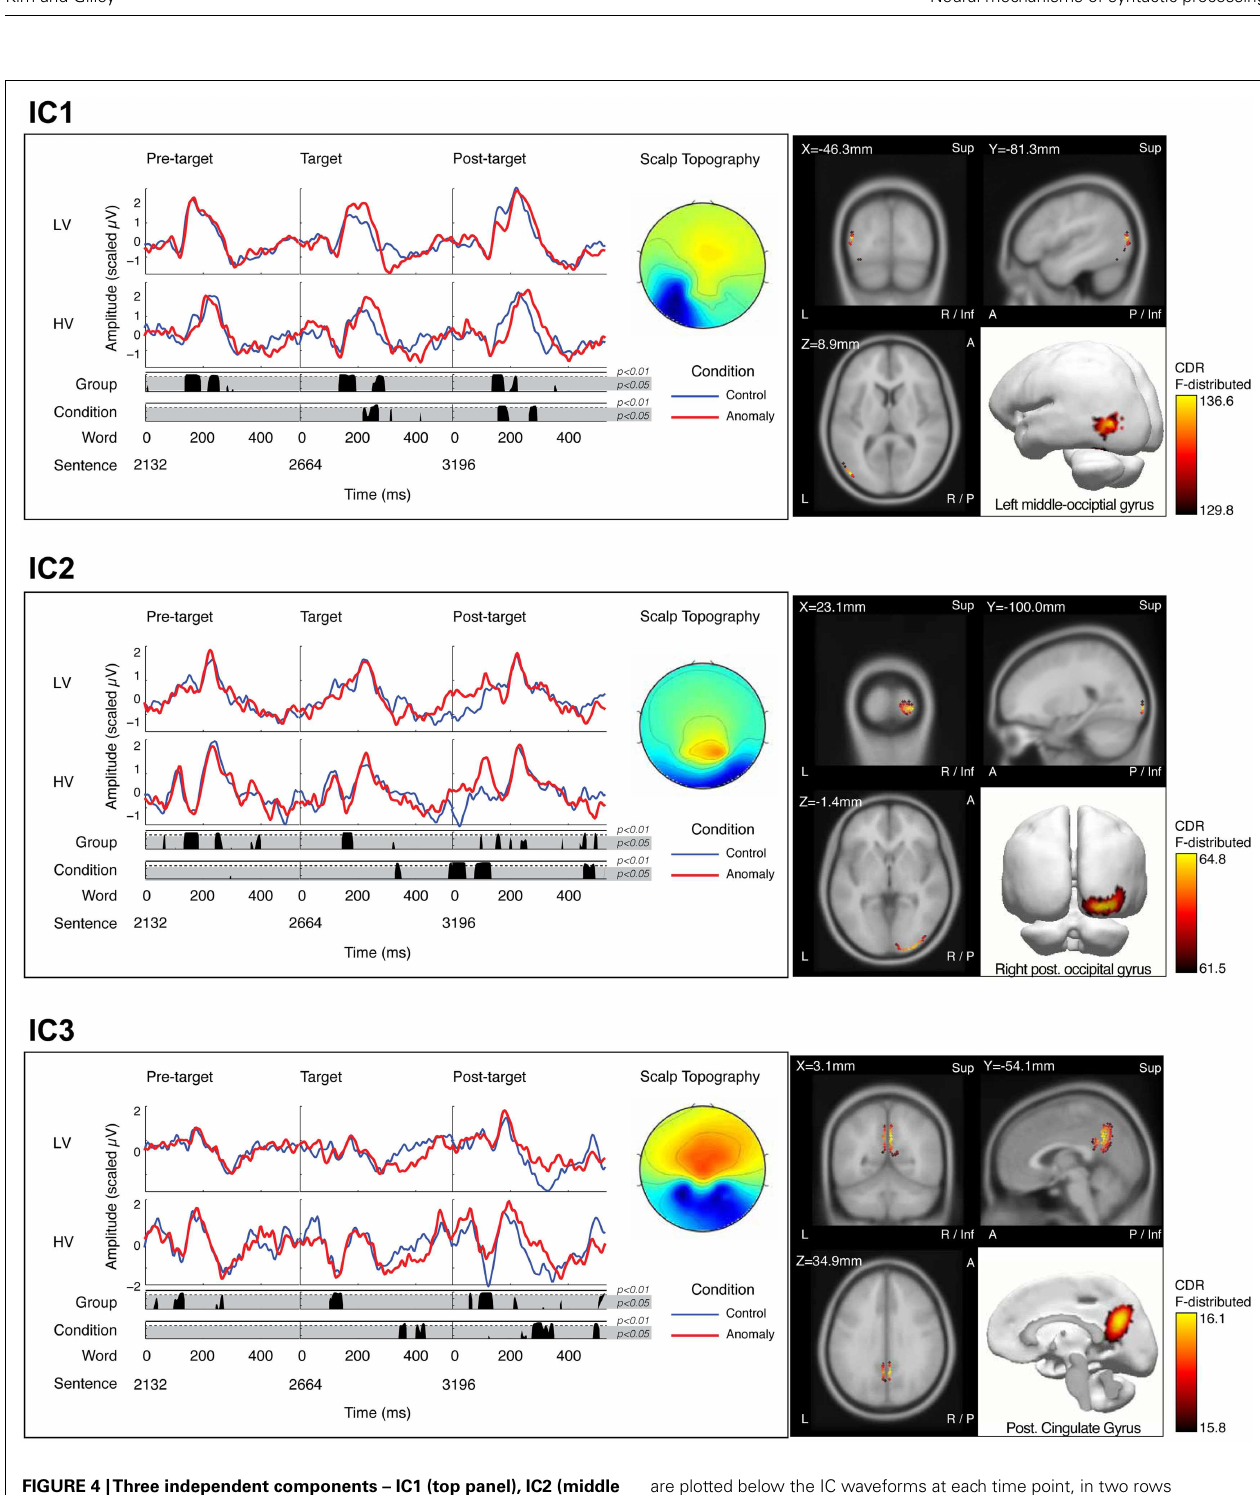
FIGURE 4 |Three independent components – IC1 (top panel), IC2 (middle panel), and IC3 (lower panel) – demonstrating significant experimental effects. Each panel contains two primary sub-panels; the left sub-panel showing the mean time series projections of each IC for the final three words of the sentence (pre-target, target, and post-target words, respectively), where the target word is either a well-formed control (blue), or an anomalous form (red). IC projections are shown separately for low-variability stimuli (LV, upper waveforms) and high-variability stimuli (HV, lower waveforms). IC waveforms are shown with positive up, although scalp polarity is determined by the spatial weights for each component. Results of the permutation t -tests